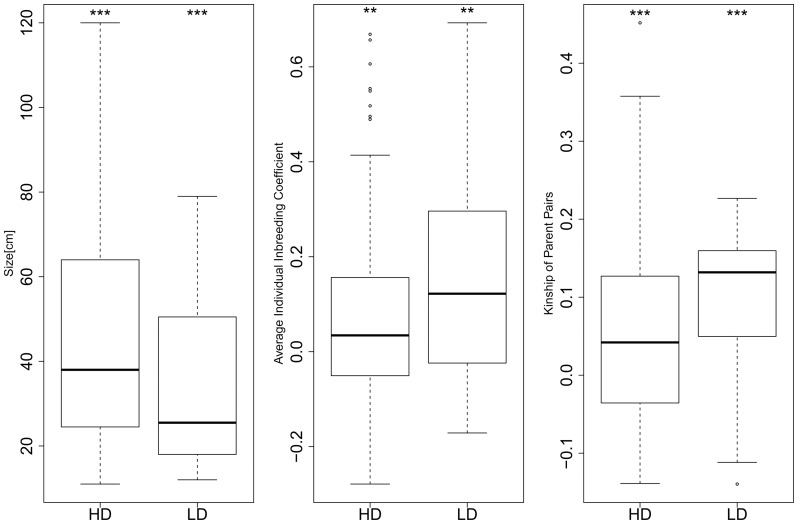
Effect of high density (HD) and low density (LD) of adult Dysoxylum malabaricum trees on A) seedling height after 21 months of growth (Median HD  =  38.0 cm, Median LD  =  25.5 cm), B) individual inbreeding coefficient (Median HD  =  0.034, Median LD  =  0.122), and C) pairwise parental kinship coefficients [32] (Median HD  =  0.042, Median LD  =  0.132), of nursery-reared D. malabaricum seedlings.Boxplots show the median and the upper and the lower quartile, the whiskers are 1.5 times the interquartile range from the box, dots outside of the whiskers are considered outliers. Significant differences are based on Wilcoxon rank sum test; * p<0.05, ** p<0.01, *** p<0.001.